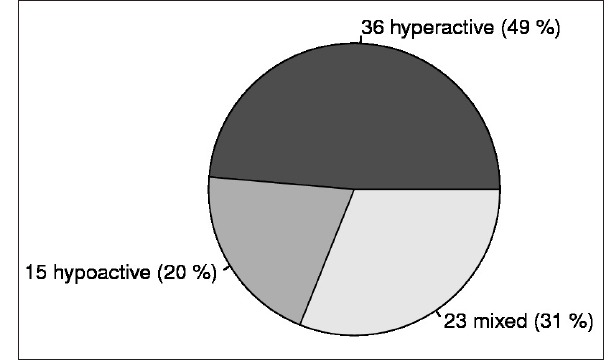
Fig. 4. Subtypes of deliria in